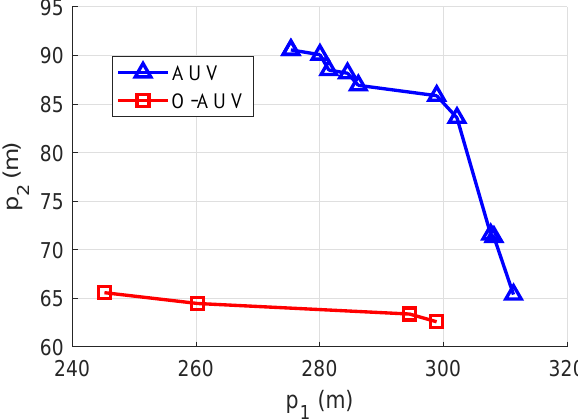
Figure 15. The Pareto front of the AUV+NSGA-II and